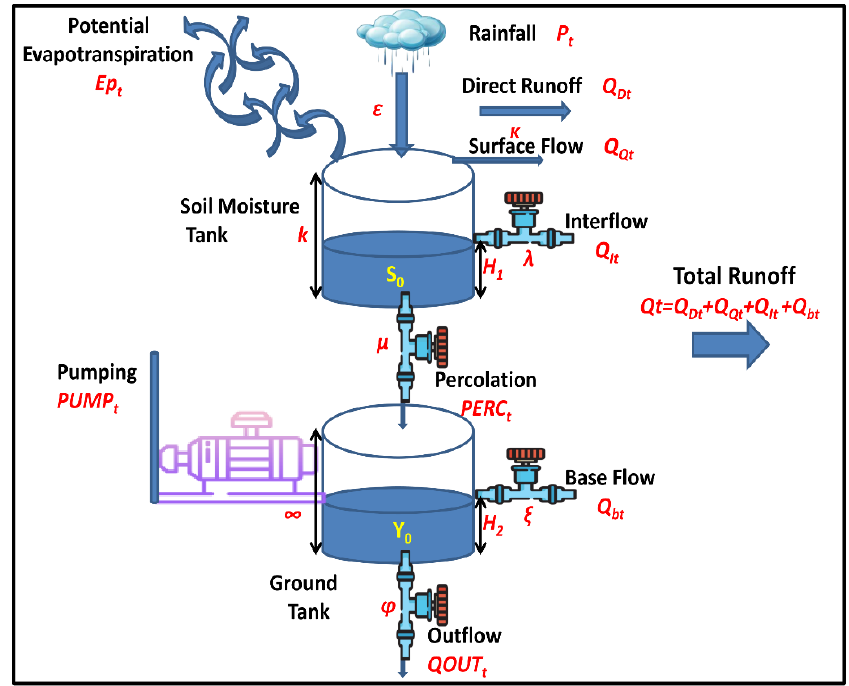
Figure 2. Schematic representation of the hydrologic processes of the conceptual hydrological model Zygos (Adapted from Kozanis et al. [38]).